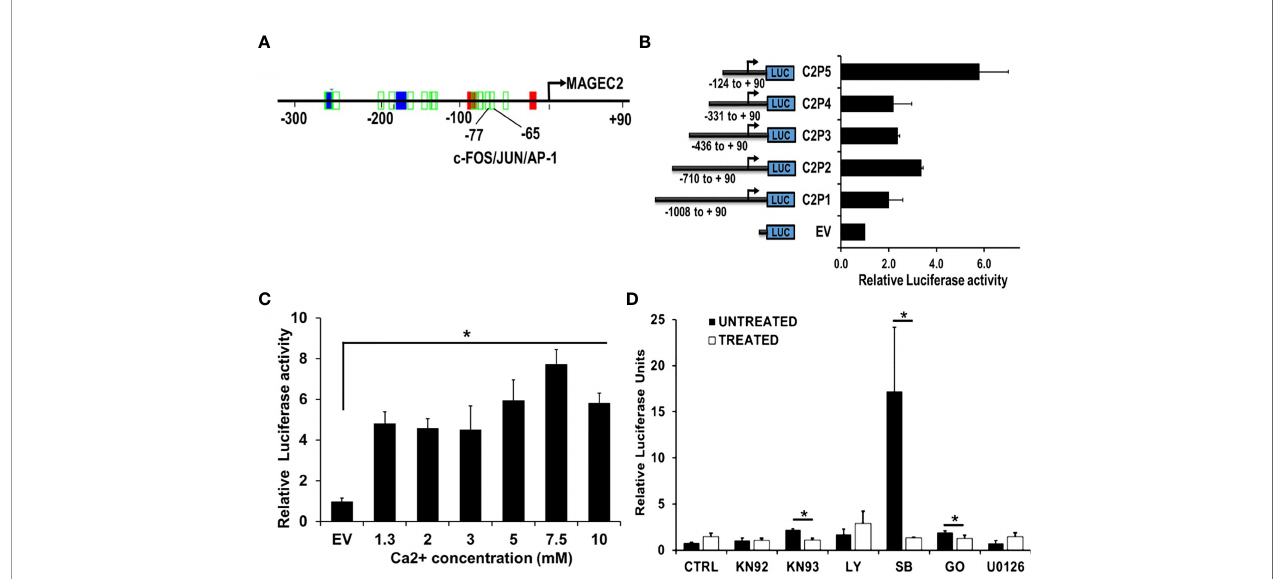
FIGURE 6 | The proximal MAGEC2 promoter is activated by high Ca+. (A) The AP-1 transcription factor binding site on the proximal promoter of MAGEC2 was identi fi ed by using the Promo V3 software. B) The proximal promoter fragments of MAGEC2 truncated as indicated were cloned into pGL4 basic, then used to transfect HEK293T cells. For luciferase activity, HEK293T cells transfected with the empty vector (EV) or the MAGEC2 truncated promoter fragments and Renilla luciferase expressing vector (for transfection control) were cultured in complete medium with or without high (5.0 mM) Ca 2+ . Luciferase expression at high Ca 2+ was assessed relative to the control. (C) HEK293T cells transfected with C2P5 from (B) above were cultured in complete medium supplemented with the indicated concentrations of Ca 2+ and the luciferase activity assessed as in (B) above. (D) HEK293 T cells transfected as in (B, C) above were cultured in complete medium and high Ca 2+ with or without the indicated inhibitors. Luciferase activity was measured 48 h post treatment as in (B) above. Luciferase activity as normalized to the DMSO control. EV: empty vector; DMSO: Dimethylsufoxide vehicle control; UNT (untreated, drug free); KN92: inactive Ca 2+ /camodulin kinase inhibitor; KN93 active Ca 2+ /camodulin kinase inhibitor; LY: LY 294002, PI3 kinase inhibitor; SB: SB 203580 p38 MAP kinase inhibitor; GO: Gö 6976, Ca 2+ dependent PKC inhibitor; U0126, MEK inhibitor. * denotes p < 0.05, ** denotes p < 0.01, *** denoted p < 0.0001. Statistical signi fi cance was determined by Student ’ s T-Test and two-way ANOVA, where (B, C) were quanti fi ed to have a statistical signi fi cance of </=